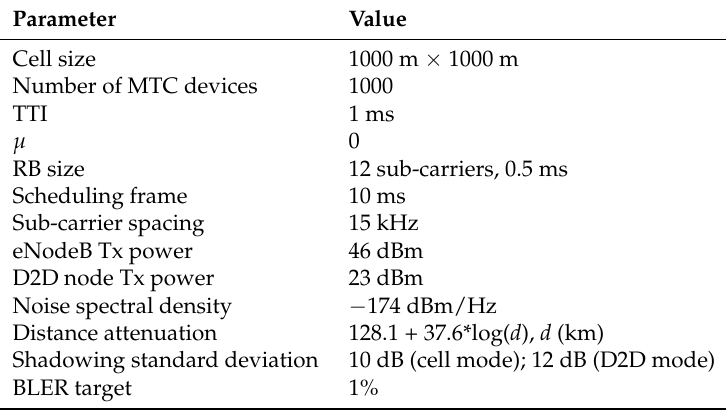
Table 2. Simulation